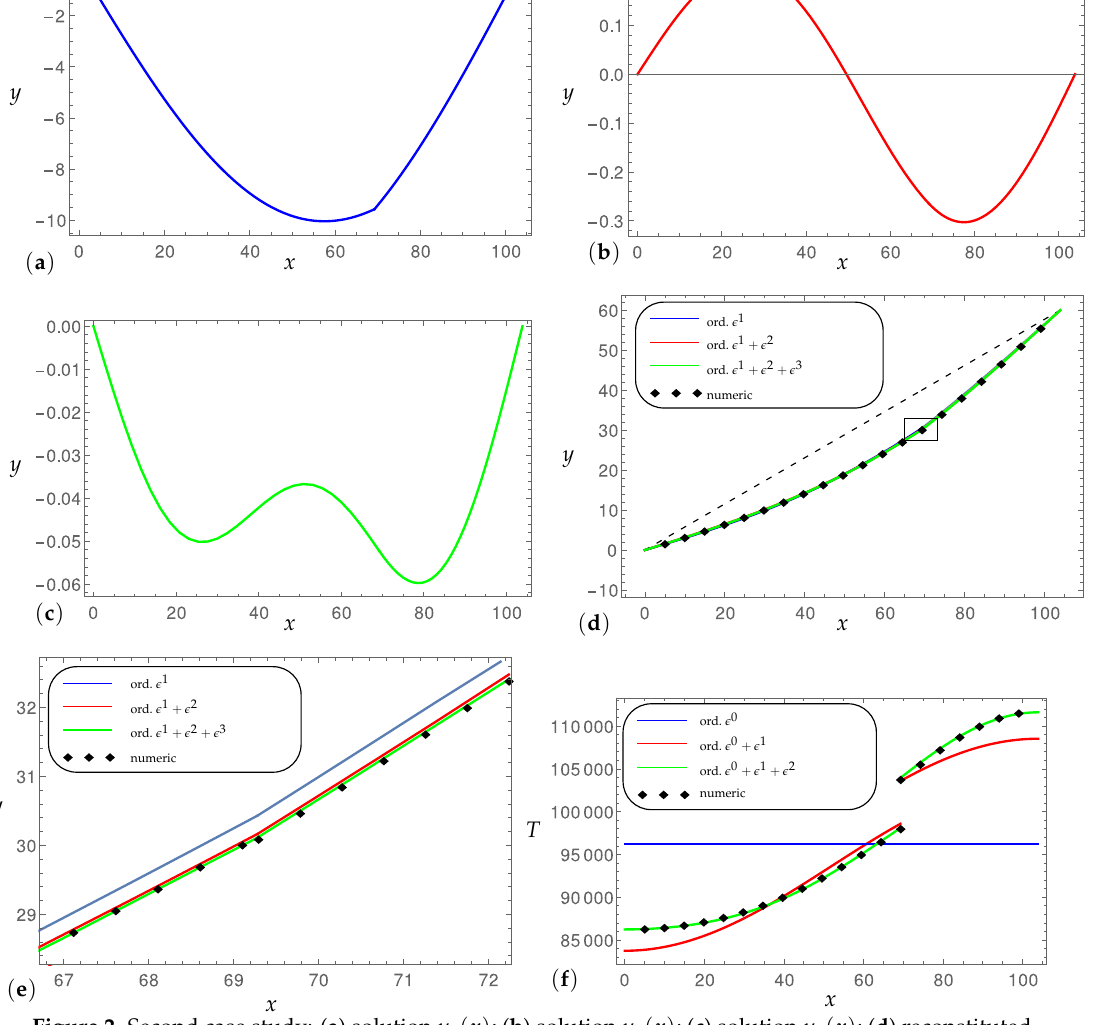
Figure 2. Second case study: ( a ) solution y 1 ( x ) ; ( b ) solution y 2 ( x ) ; ( c ) solution y 3 ( x ) ; ( d ) reconstituted cable configuration (dashed line: the chord; the box indicates the boundaries of ( e )); ( e ) zoom of the reconstituted cable configuration; ( f ) normal force T ( x ) ; [ x , y ] = m ; [ T ] = N